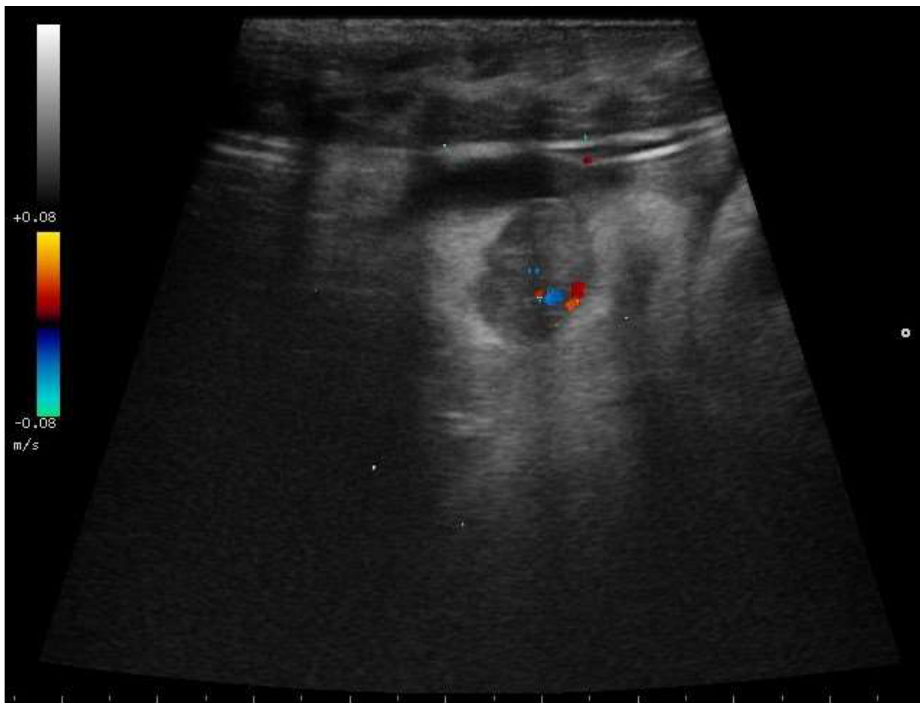
Figure 10. Gravid female boa in the first month after ovulation—flow towards the transducer is depicted in red, while flow away from the transducer is shown in blue. In 100% of females who gave birth to live and viable offspring, it was possible to observe embryonic vesicle, and blood flow was highlighted by color Doppler.